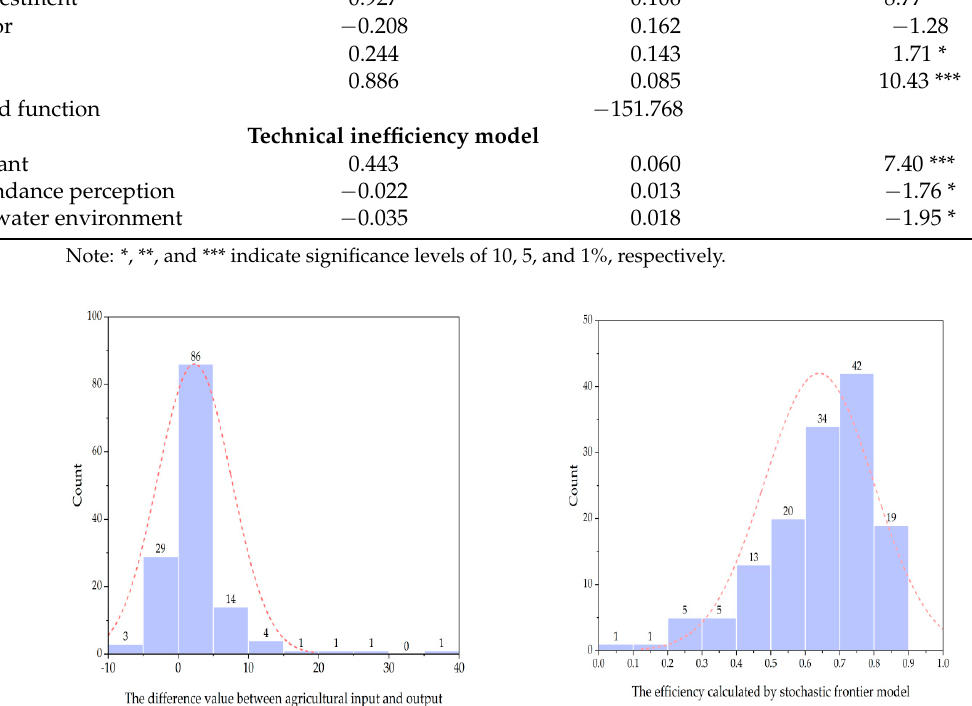
Table 5. Questionnaire reliability analysis results.